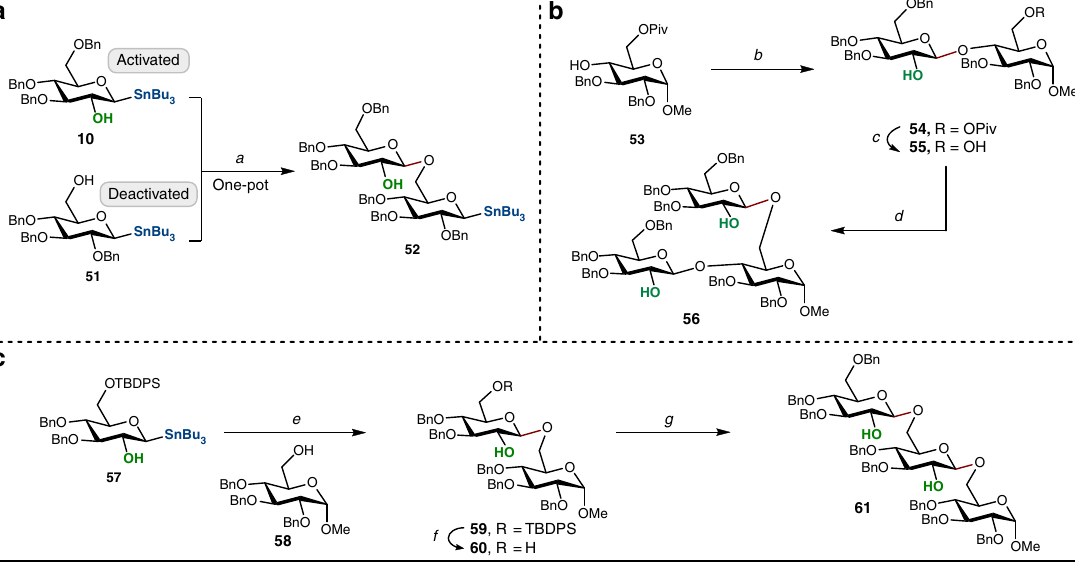
Fig. 4 Orthogonal and sequential glycosylations. a PhI(OH)OTs, Zn(OTf) 2 , CHCl 3 , 23 °C, 36 h, 43%; b 10 , PhI(OH)OTs, Zn(OTf) 2 , CHCl 3 , 23 °C, 36 h; c MeONa, MeOH, 50 °C, 10 h, 55% over two steps; d 10 , PhI(OH)OTs, Zn(OTf) 2 , CHCl 3 , 23 °C, 48 h, 56%; e PhI(OH)OTs, Zn(OTf) 2 , CHCl 3 , 23 °C, 36 h, 82%; f TBAF, THF, 23 °C, 24 h, 88%; g 10 , PhI(OH)OTs, Zn(OTf) 2 , CHCl 3 , 23 °C, 36 h, 71%